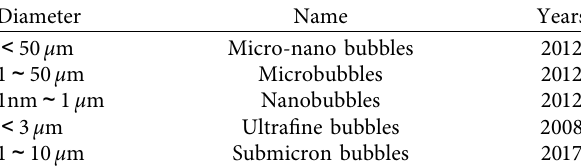
Table 1: Definition of bubbles of different